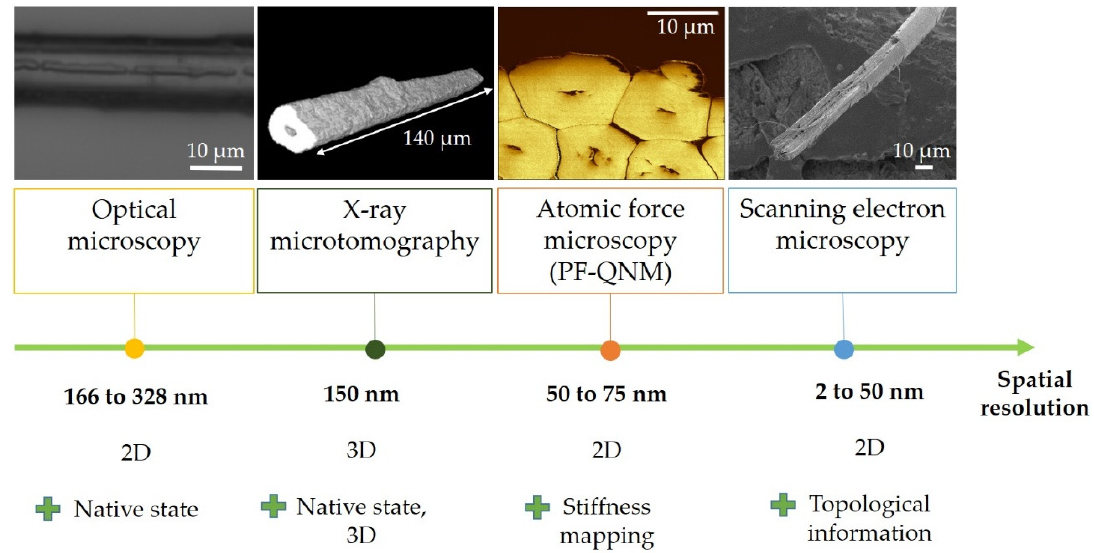
Figure 2. Multi-scale observation techniques and distinctive characteristics exploited in this study .